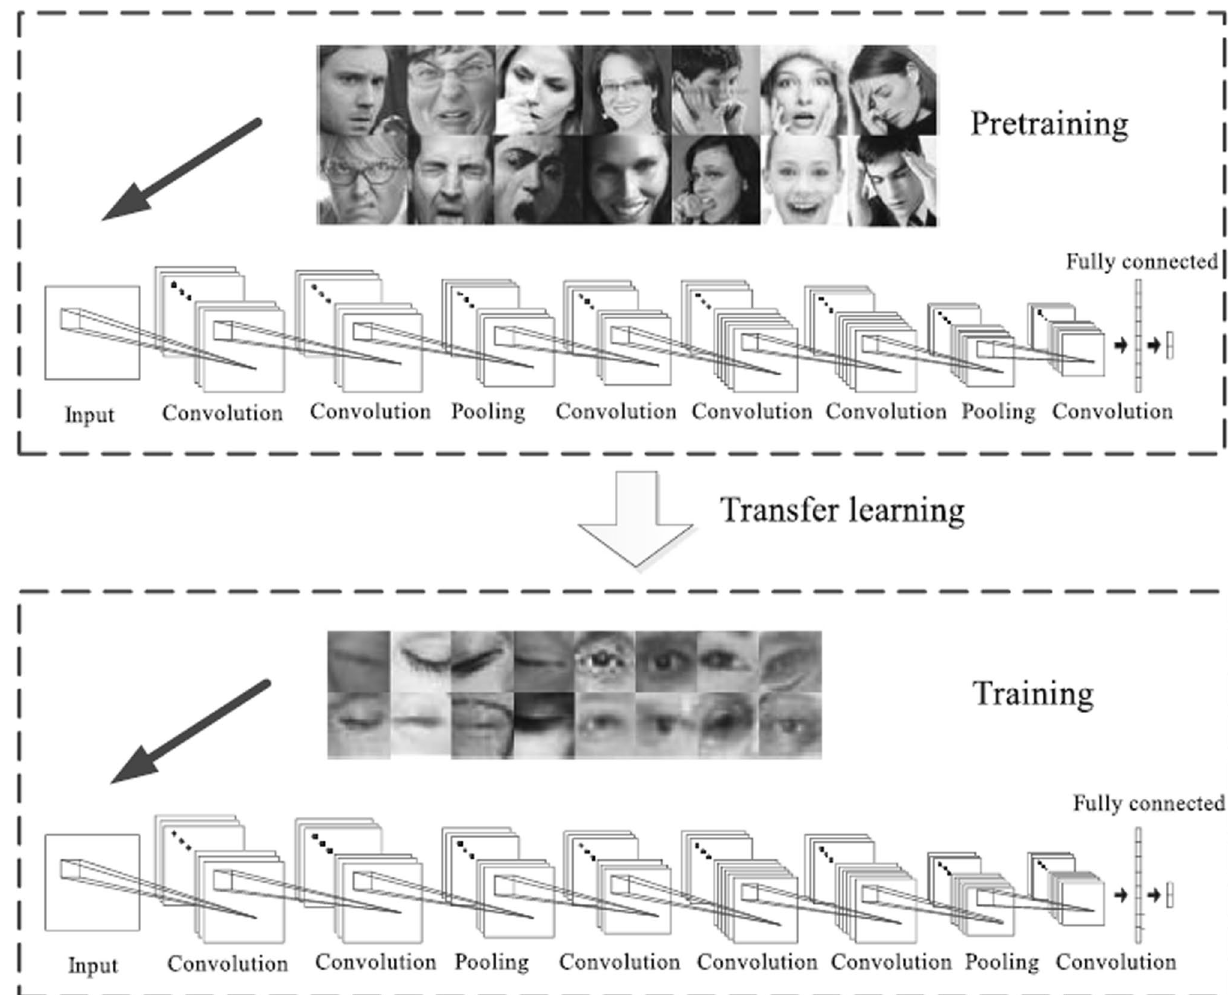
Fig. 2 Transfer learning framework for eye state recognition [26]